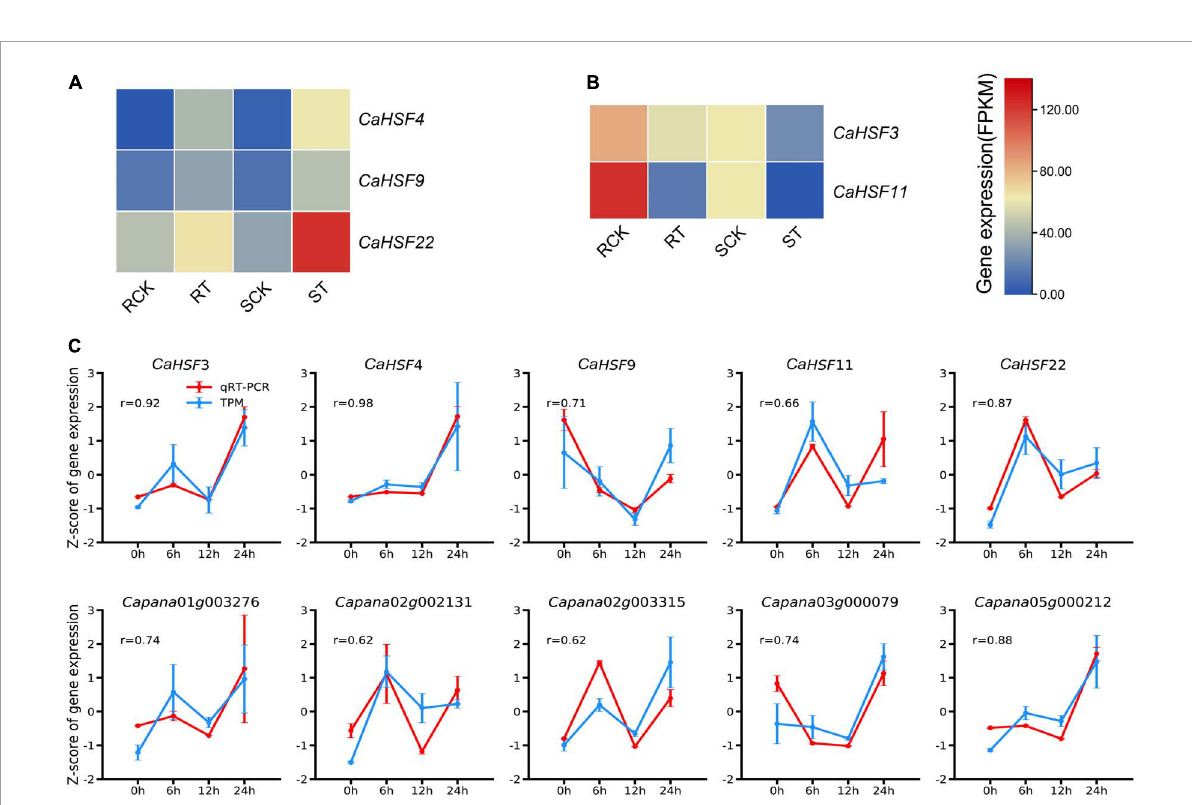
FIGURE10 Expression of selected key genes in different pepper varieties. (A,B) Expression of CaHSFs in heat-tolerant variety 17CL30 and heat-susceptible variety 05S180 after treated at 40 ◦ C for 28 h. RCK: control 17CL30; RT: treated 17CL30; SCK: control 05S180; ST: treated 05S180. (C) RNA-Seq and qRT-PCR data of the expression profiles of ten selected genes in pepper line 6421 leaves after treated at 42 ◦ C for 0, 6, 12, and 24 h. Error bars represent the standard deviation ( n = 3). r = Pearson’s(r) correlation coefficient to describe the correlation between normalized expression values measured by RNA-Seq and qRT-PCR (normalized relative to CaUBI3